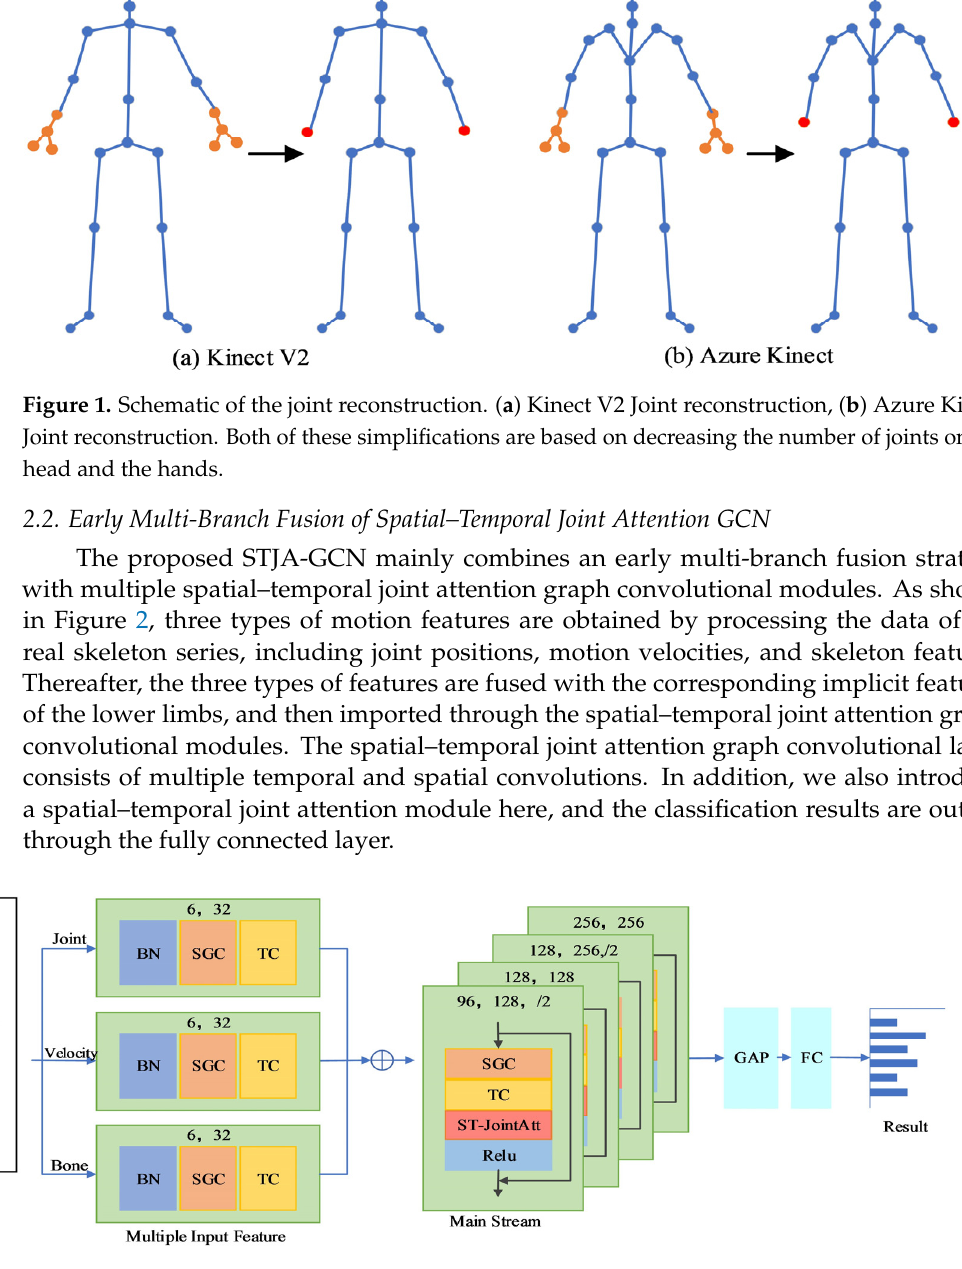
Figure 1. Schematic of the joint reconstruction. ( a ) Kinect V2 Joint reconstruction, ( b ) Azure Kinect Joint reconstruction. Both of these simpli fi cations are based on decreasing the number of joints on the head and the hands.